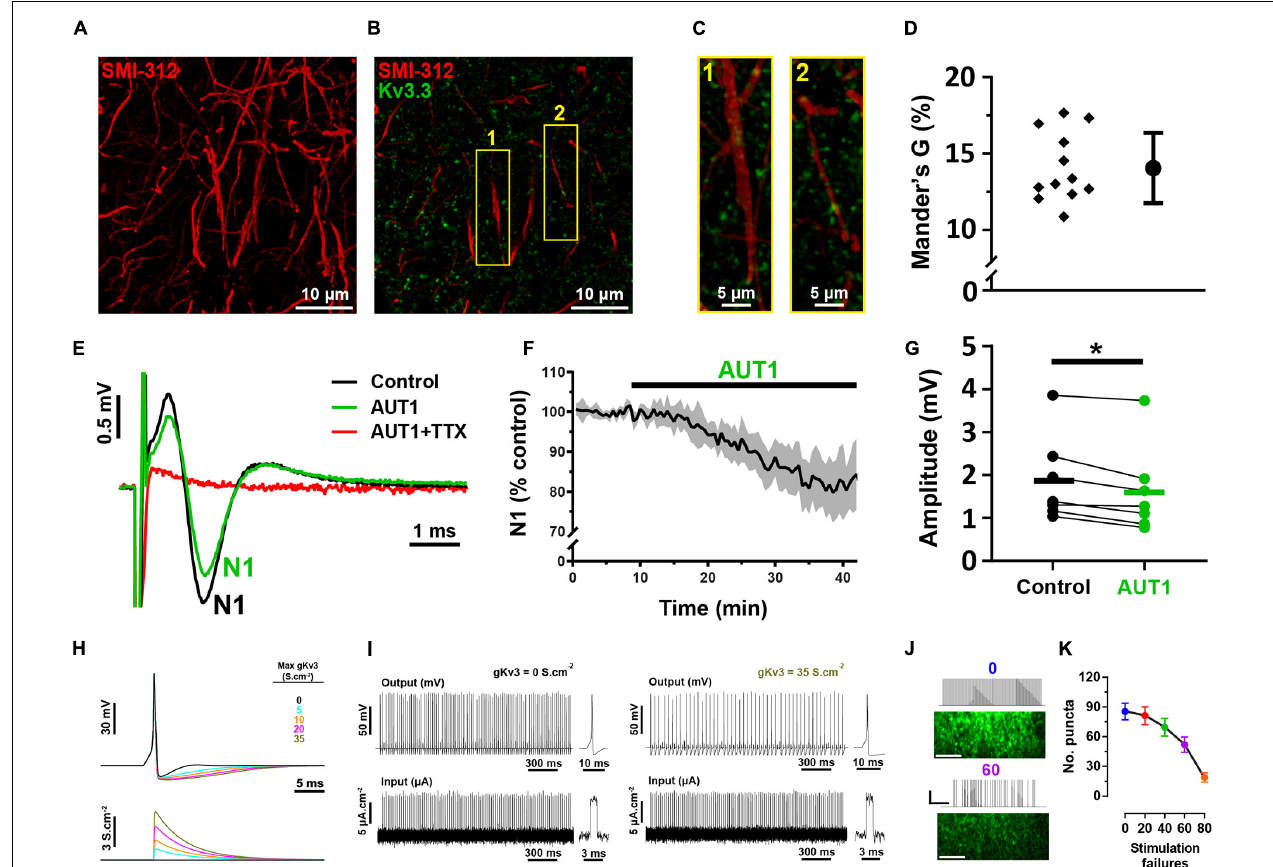
FIGURE 7 | Immunolabeling and mathematical modeling reveal a moderate Kv3 mediated effect on bouton elimination via axonal action potential propagation. (A) Confocal image of axons in the molecular layer of the DCN (sagittal slice), labeled with the neurofilament marker SMI-312. Image shows the maximum fluorescence intensity from an entire z-stack (28 images taken at intervals of 45 nm). (B) Composite image showing the expression of Kv3.3 K + channels (green) and the neurofilament marker SMI-312 (red) in the molecular layer. (C) 3D projection images (created using the volume viewer function in imageJ) from the yellow regions of interest labeled 1 and 2 in panel (B) . (D) Mander’s G correlation coefficient indicating the percentage of green (Kv3.3) fluorescence overlapping with axonal red (SMI-312) fluorescence ( N = 2, n = 3, fields = 12). (E) Pre-synaptic fiber volleys (N1) obtained using extracellular recordings from the molecular layer in response to a 250 µ A stimulation of the parallel fibers, in the control (black), AUT1 (green), and AUT1+TTX (red) conditions. (F) Time course for the effects of AUT1 on the amplitude of N1. Data are plotted as a percentage of control and represent the mean ± SEM ( n = 6). (G) Perfusion of AUT1 significantly decreased the amplitude of N1 ( n = 7). (H) Simulated single action potentials (top) represented as a function of varying Kv3 K + conductance magnitudes (bottom). (I) Simulated action potentials (top) in response to 50 Hz stimulus trains (bottom), in absence (left, 0 S.cm - 2 gKv3) and in presence of a Kv3 K + conductance (right, 35 S.cm - 2 gKv3). Insets represent simulated action potentials (top) elicited by single stimulus pulses (bottom). (J) SyGCaMP2 fluorescence responses obtained from the molecular-fusiform layer border in response to continuous 50 Hz stimulus train (top), or a 50 Hz stimulus train with 60 stimulus pulses omitted at random locations (bottom). Scale bars in fluorescence images = 20 µ M. Stimulus trace horizontal and vertical scale bars = 400 ms and 50 µ A, respectively. (K) Number of responding puncta as a function of the number of stimulation failures. Omitting stimulus pulses within the stimulus train significantly decreased the number of responding puncta ( n = 7). Error bars = SEM. * p <